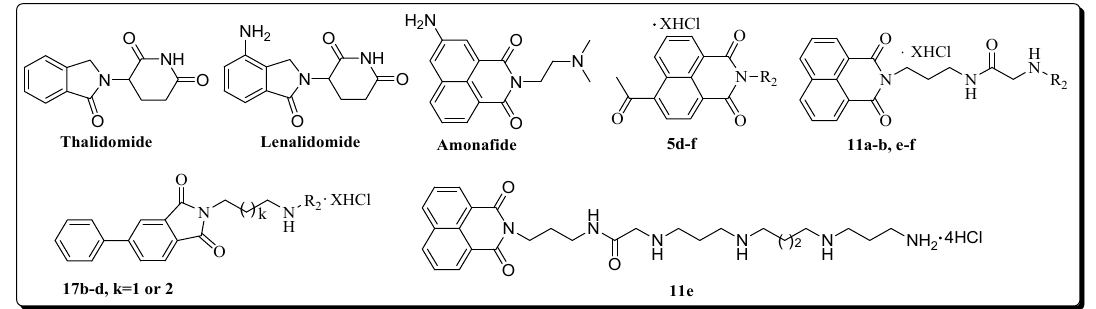
Figure 1. The structures of 5d – f , 11a – b , e – f , 17b – d , thalidomide, lenalidomide and amonafide (X = 2, 3, 4; R 2 = deprotected polyamine chain).